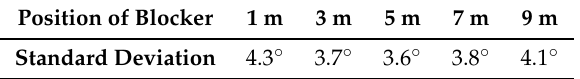
Table 2. Standard deviation of non-line of sight circumstances.